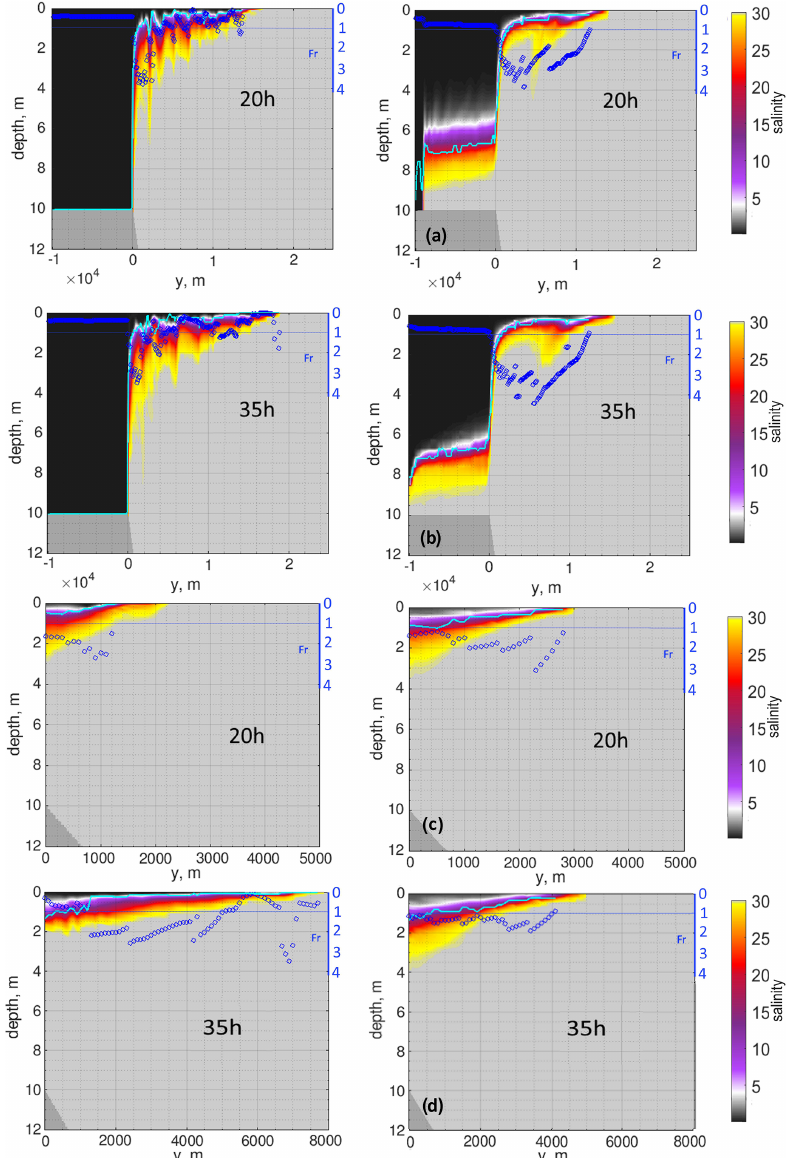
Figure 6. The salinity patterns, in practical scale, at cross sections based on runs 1 (left column) and 2 (right column) after one (20h) and two (35h) inertial periods. The upper two rows (a, b) illustrate the mouth transect, and the bottom two rows (c, d) illustrate the coastal current transect. The light blue line shows the thickness of the plume layer. The dark blue circles identify the approximate Froude numbers of the plume layer (see additional dark blue axes from 0 to 4 at the right side of each panel). The dark blue line shows the relative position of a Froude number equal to 1 for